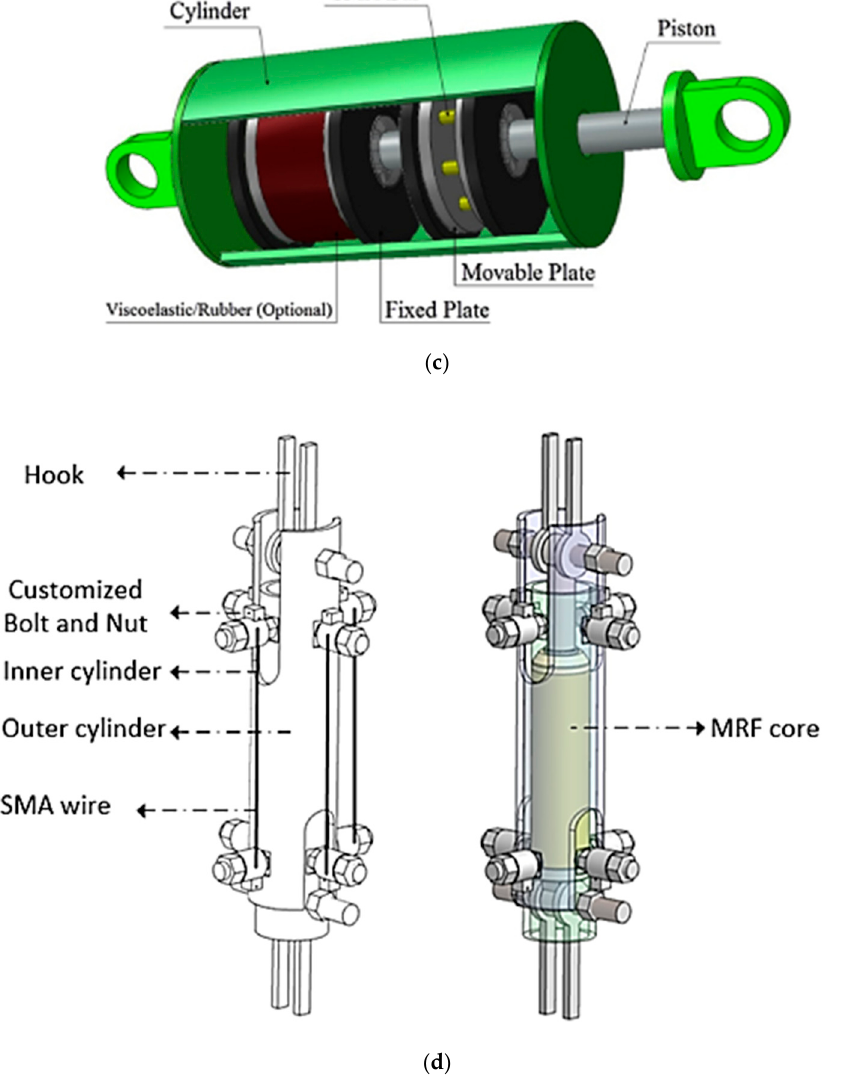
Figure 13. New generation dampers used for marine structures. ( a ) Viscous-based structural control system [55], ( b ) Magnetorheological fluid (MRF) [55], (c) The SMA damper [56], ( d ) SMA-MRF-based structural control system [55].